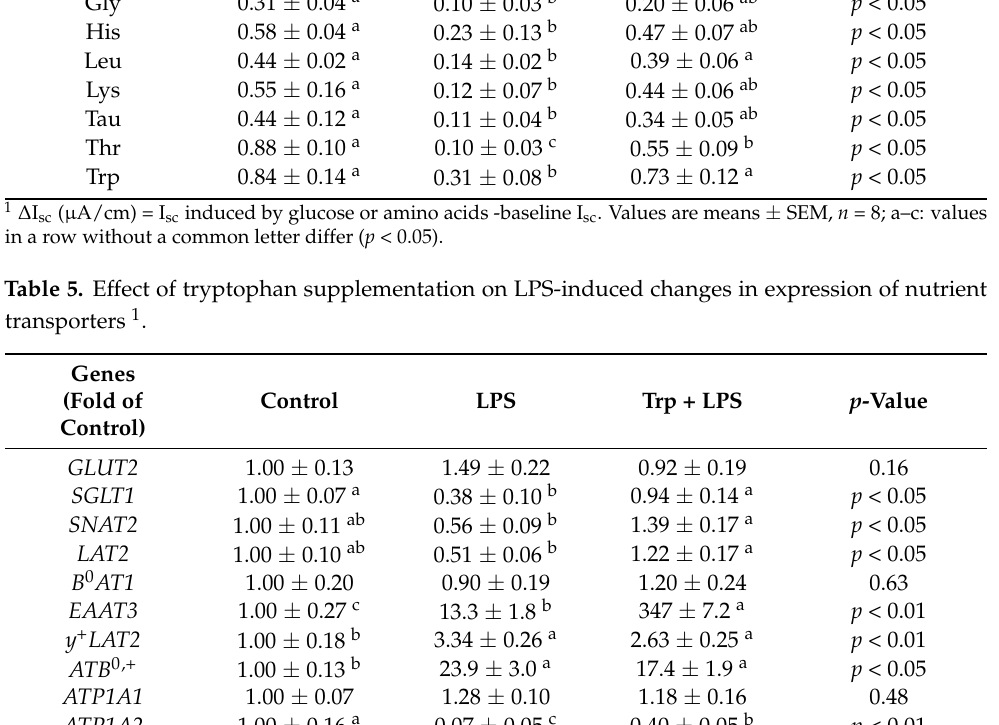
Table 4. Effects of tryptophan supplementation and LPS on changes of short-circuit current (ΔI sc ) across the jejuna of rats 1 .